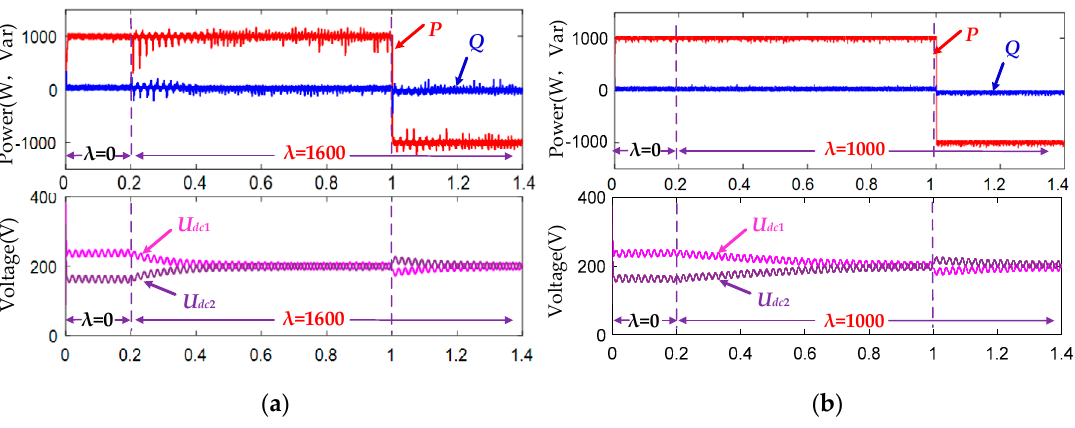
Figure 10. Simulation results with dc-link voltage offset suppression with different weighting factor λ . ( a ) λ = 1600; ( b ) λ = 1000.